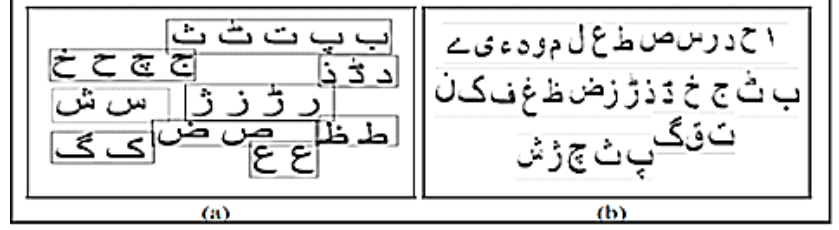
Figure 3. The Urdu characters: ( a ) the matching order of pen-strokes among Urdu characters; ( b ) groups of Urdu isolated characters based on the number of strokes [21].